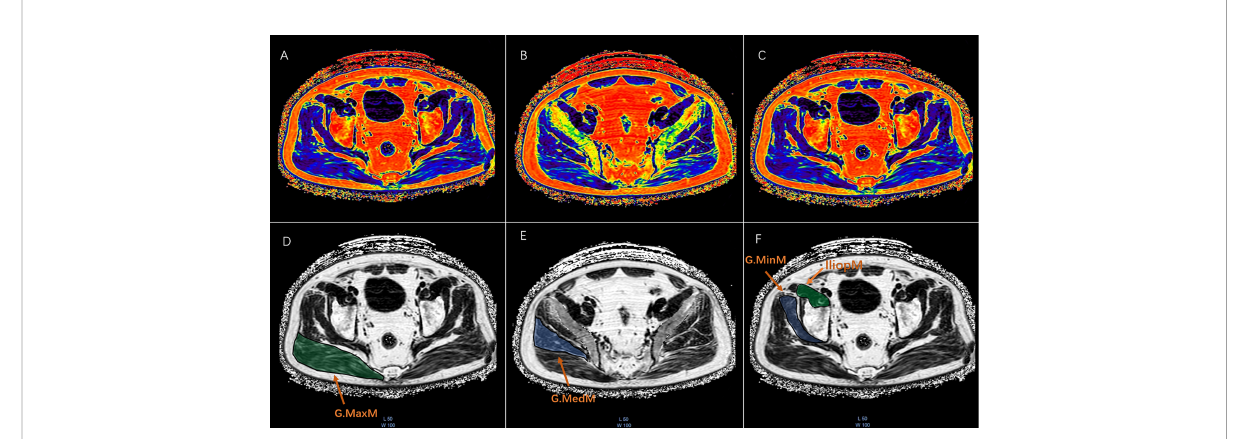
FIGURE 2 The ROI drawn freehand was placed at the maximum CSA of the fat fraction plot on the axial map of the right gluteus maximus (G.MaxM), gluteus medius (G.MedM), gluteus minimus (G.MinM), and iliopsoas muscle (IliopM). Each ROI was plotted along the edge of the muscle to obtain the PDFF and CSA as shown in the pseudocolor and FF maps of G.MaxM (A, D) , G.MedM (B, E) , G.MinM, and IliopM (C, F)